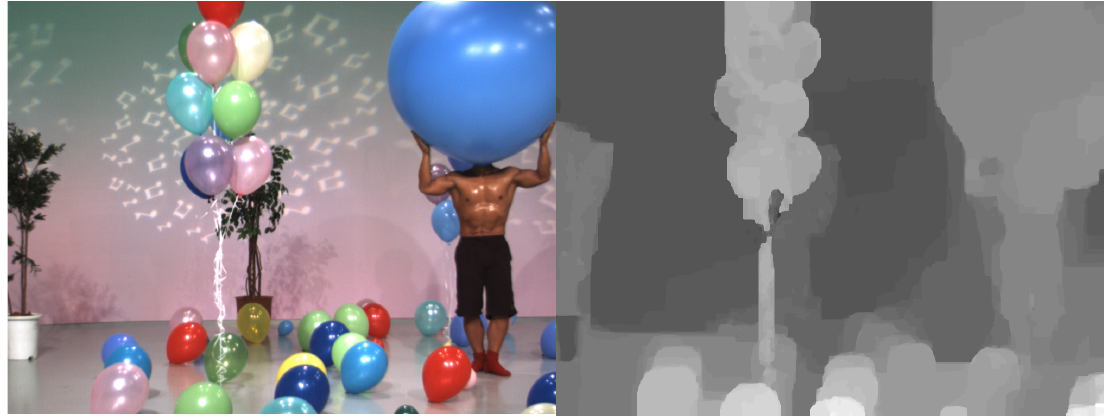
Figure 1. MVD consisting of a texture image ( left ) and its corresponding depth map ( right